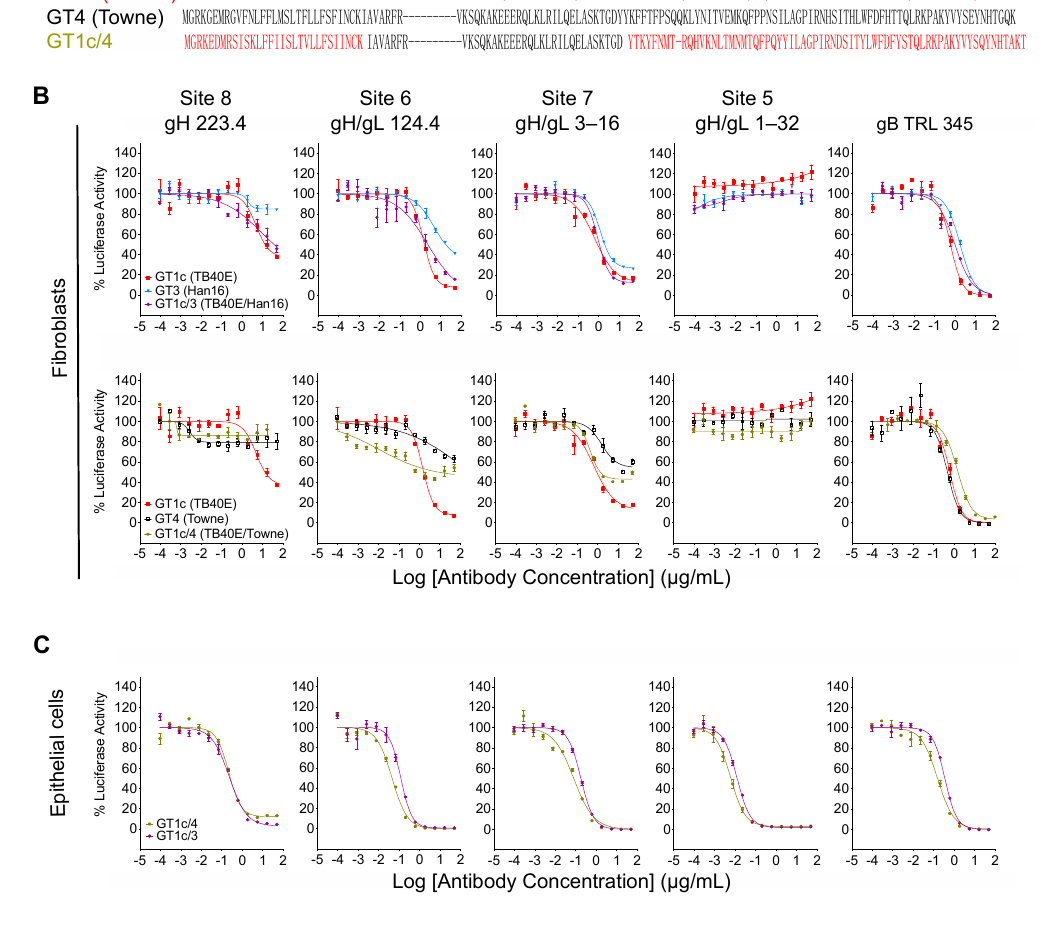
Figure 6. Inhibitory activity maps to the polymorphic N-terminal region of gO. ( A ) Predicted gO amino acid sequences from CMV strains TB40/E (red), Towne (black), and Han16 (blue) were aligned using clustalW to illustrate the respective sequences in intrastrain gO chimeras GT1c/3 and GT1c/4. Intrastrain gO chimeric viruses GT1c/3 and GT1c/4 were used in fibroblast ( B ) or epithelial cell ( C ) entry neutralizing assays as described in Figure 3. Data from chimeras encoding full-length gOs that comprise parts of each intrastrain gO chimera are included for comparison.